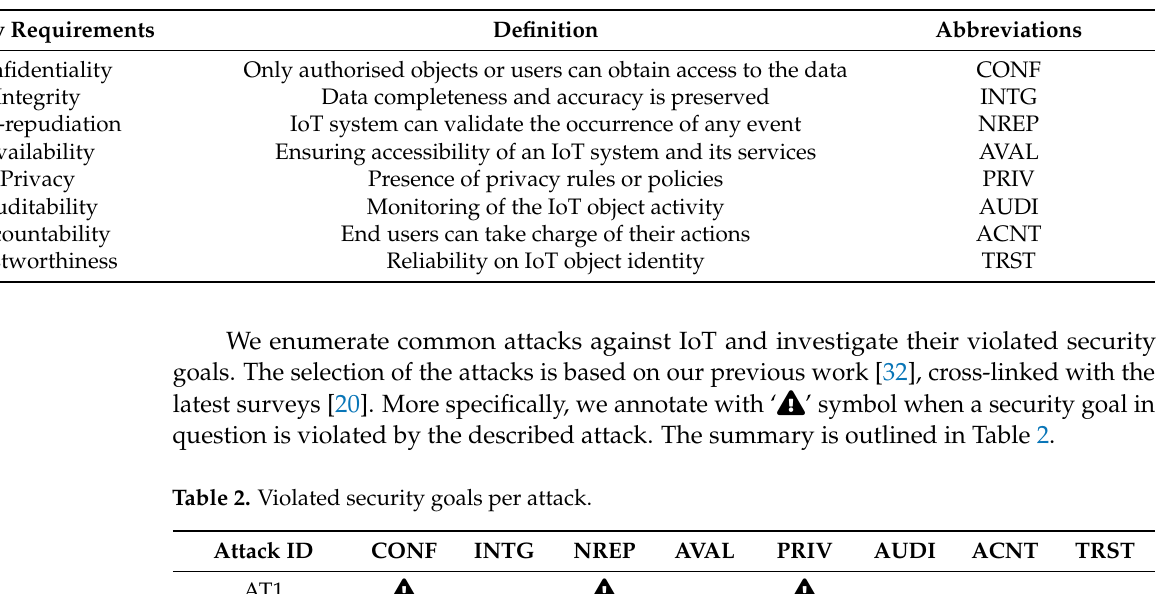
Table 1. IoT Security goals as defined by IAS octave.